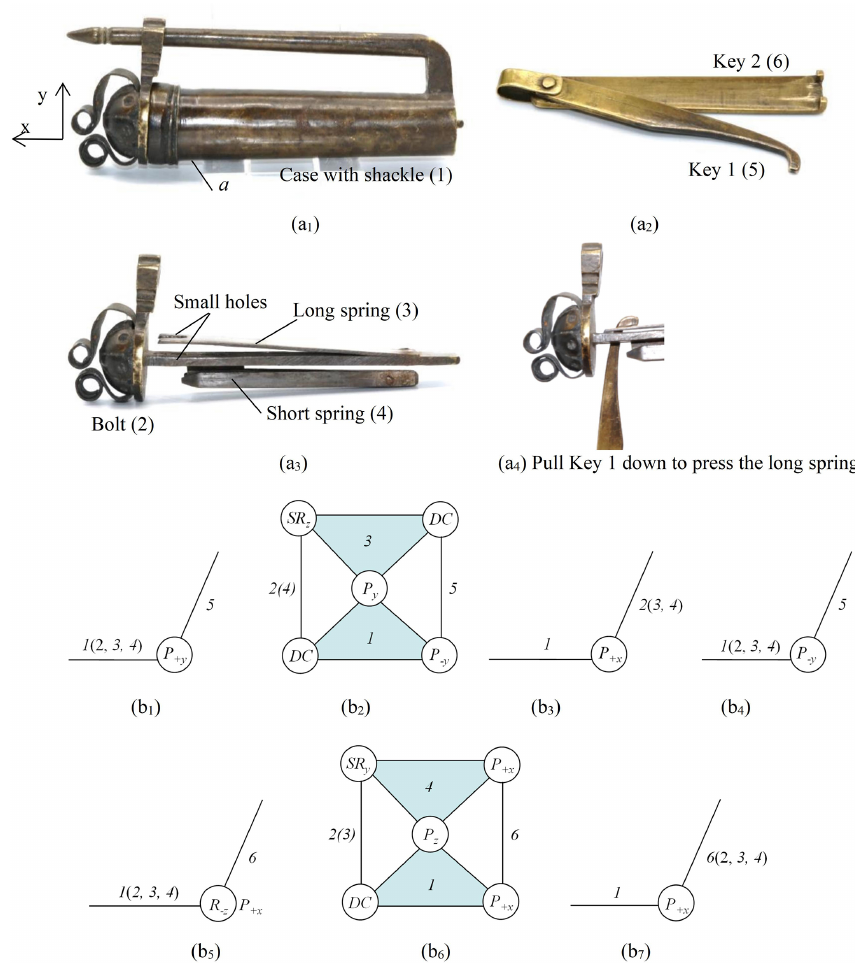
Figure 7. Copper padlock with poking hole – with two keys (Schell Collection, Graz,